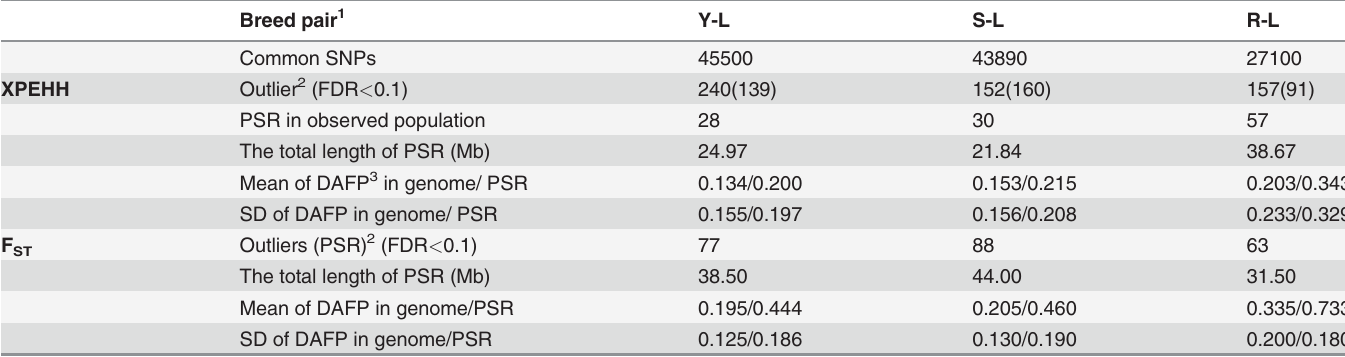
The empirical distributions of all test statistics for each breed/breed-pair are clearly illustrated. Fig. 1 (A, B, C, D) plots the distributions of the LRH, Tajima ’ s D, XPEHH and F ues across all autosomes for Yorkshire and Yorkshire-Landrace. The standardized LRH and XPEHH approximately followed a standard normal distribution, as pointed out by Sabeti et al.